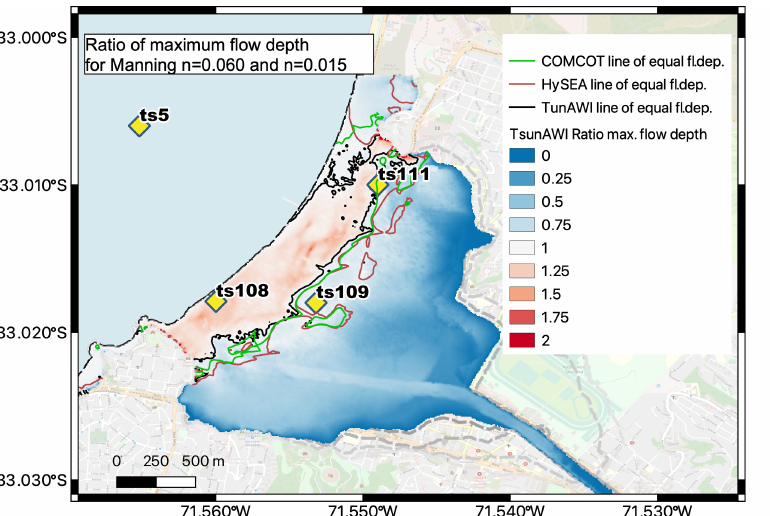
Figure 15. Ratio of the maximum flow depth obtained for the extreme Manning values (flow depth ( n = 0.06)/flow depth ( n = 0.015)) in the intersection of inundation areas in Viña del Mar. Example that summarizes the outcomes of Experiment 1730. Basemap: © OpenStreetMap